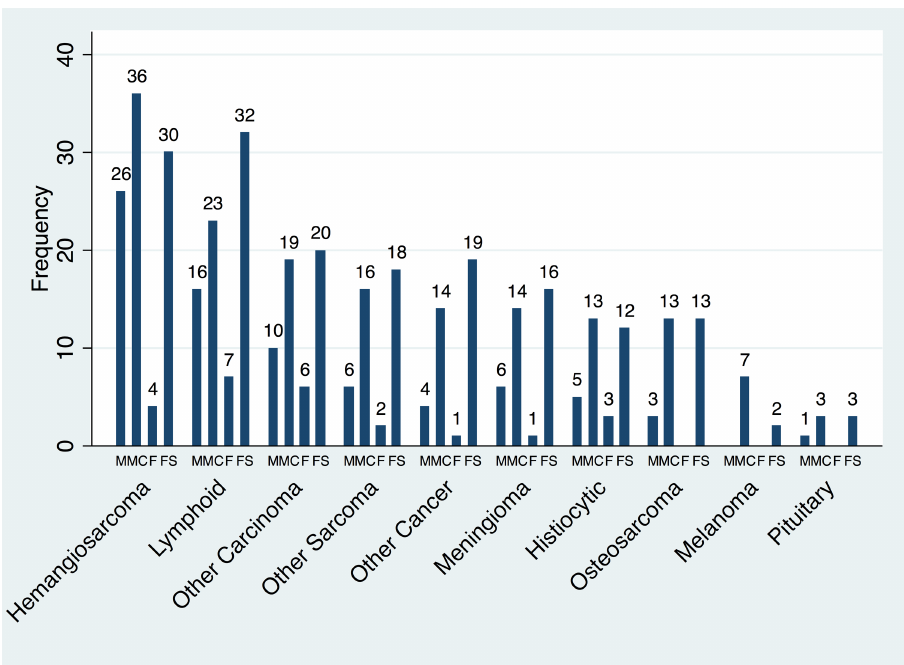
Fig 6. Histologic types of cancer diagnosed by sex. Bar graph showing frequency of tumor type leading to death in golden retriever dogs categorized by sex and spay or neuter status. M = intact male, MC = castrated male, F = Intact female, FS = spayed female.